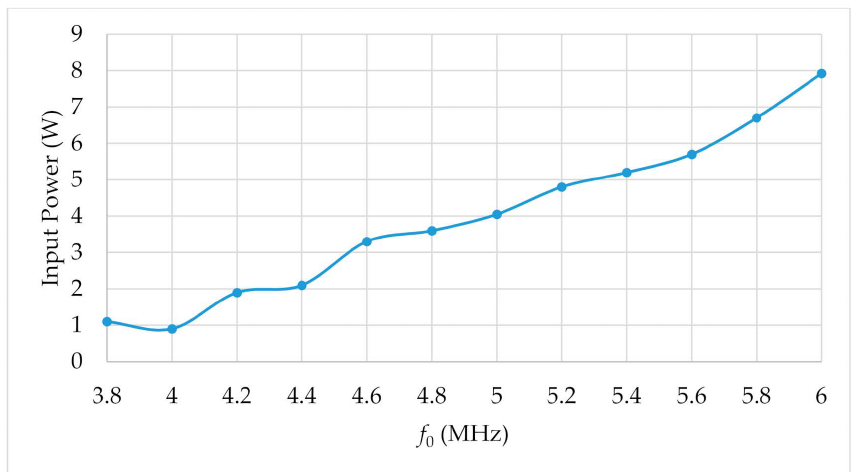
Figure 11. Input power versus resonant frequency.